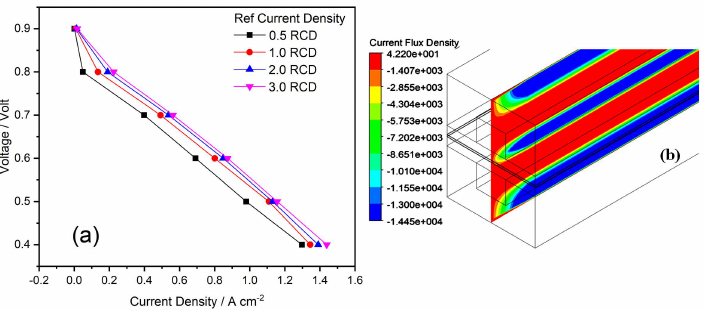
Figure 7. ( a , b ) Effects of RCD on PEMFC performance: ( a ) Polarization curves of RCD; and ( b ) Con- tours of RCD at 0.6 V.